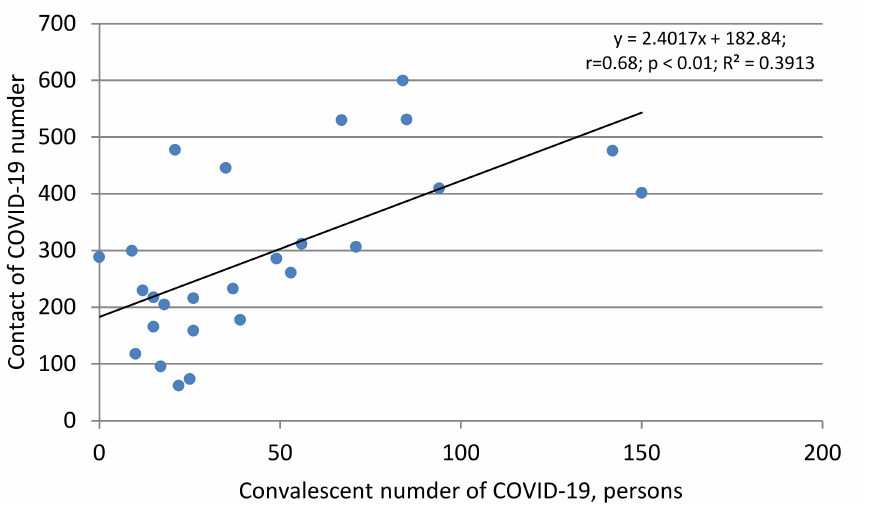
Figure 8. Correlation between the number of convalescents and COVID-19 contacts. The equation, regression, correlation coefficient value (r), reliability relation ( p ), and the coefficient of determination (R 2 ) are